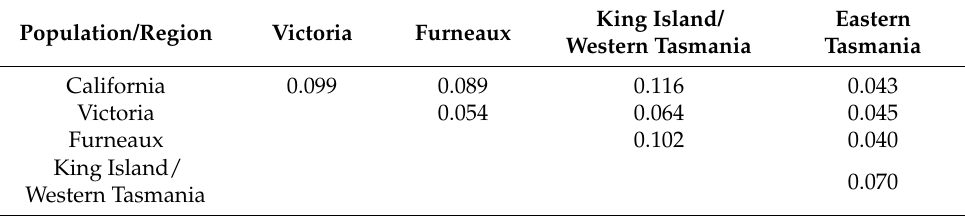
Table 2. Pairwise F ST values among Californian population and native regions of Eucalyptus glob- ulus . The analysis was based on six nuclear microsatellite loci and all pairwise comparisons were significantly different from zero ( p < 0.001) based on 999